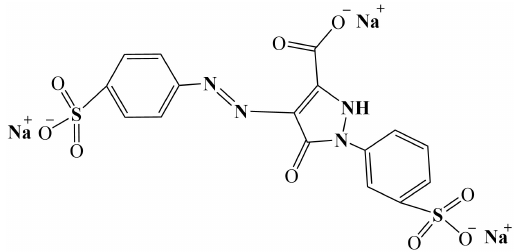
Figure 1. The molecular structure of tartrazine.